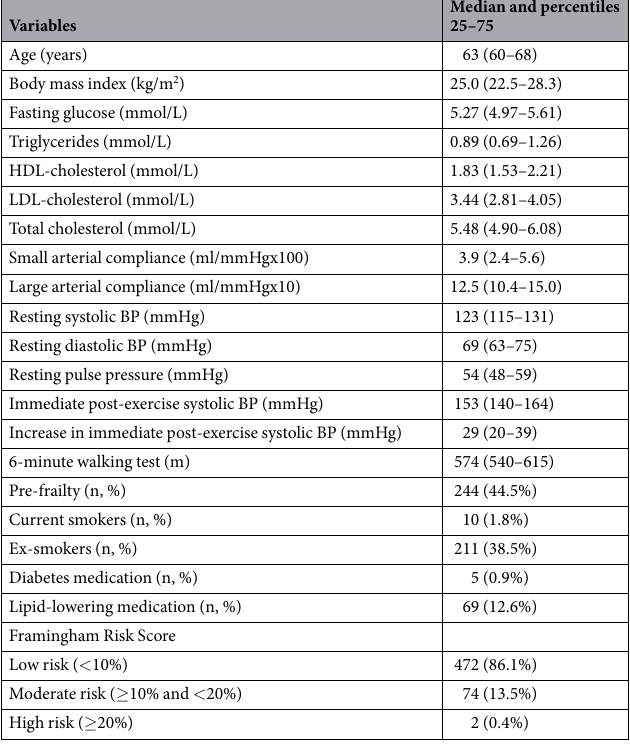
Table 1. Characteristics of the participants (n = 548). Abbreviations: BP, blood pressure. Categorical variables are expressed as absolute (n) and relative (%)